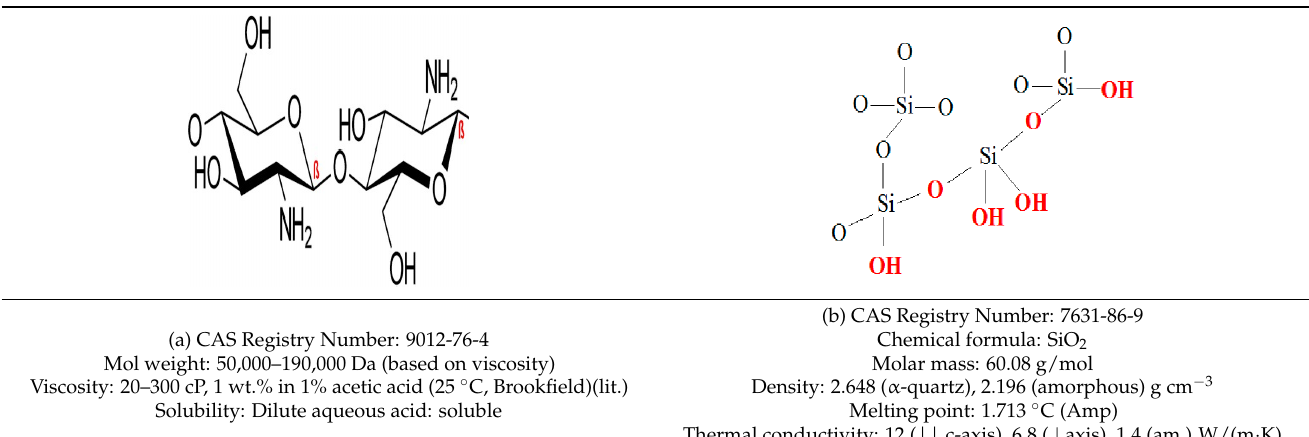
Table 1. The structure and properties of the key elements used for preparing chitosan (a) and nano-silicon dioxide (b).